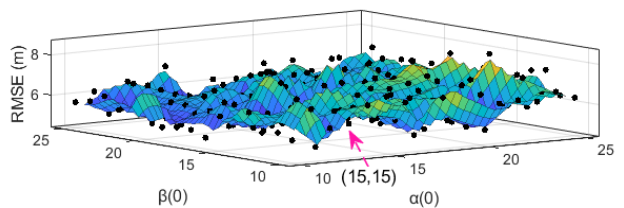
14 of 19 Table 1. Parameter settings. Initialization Parameter